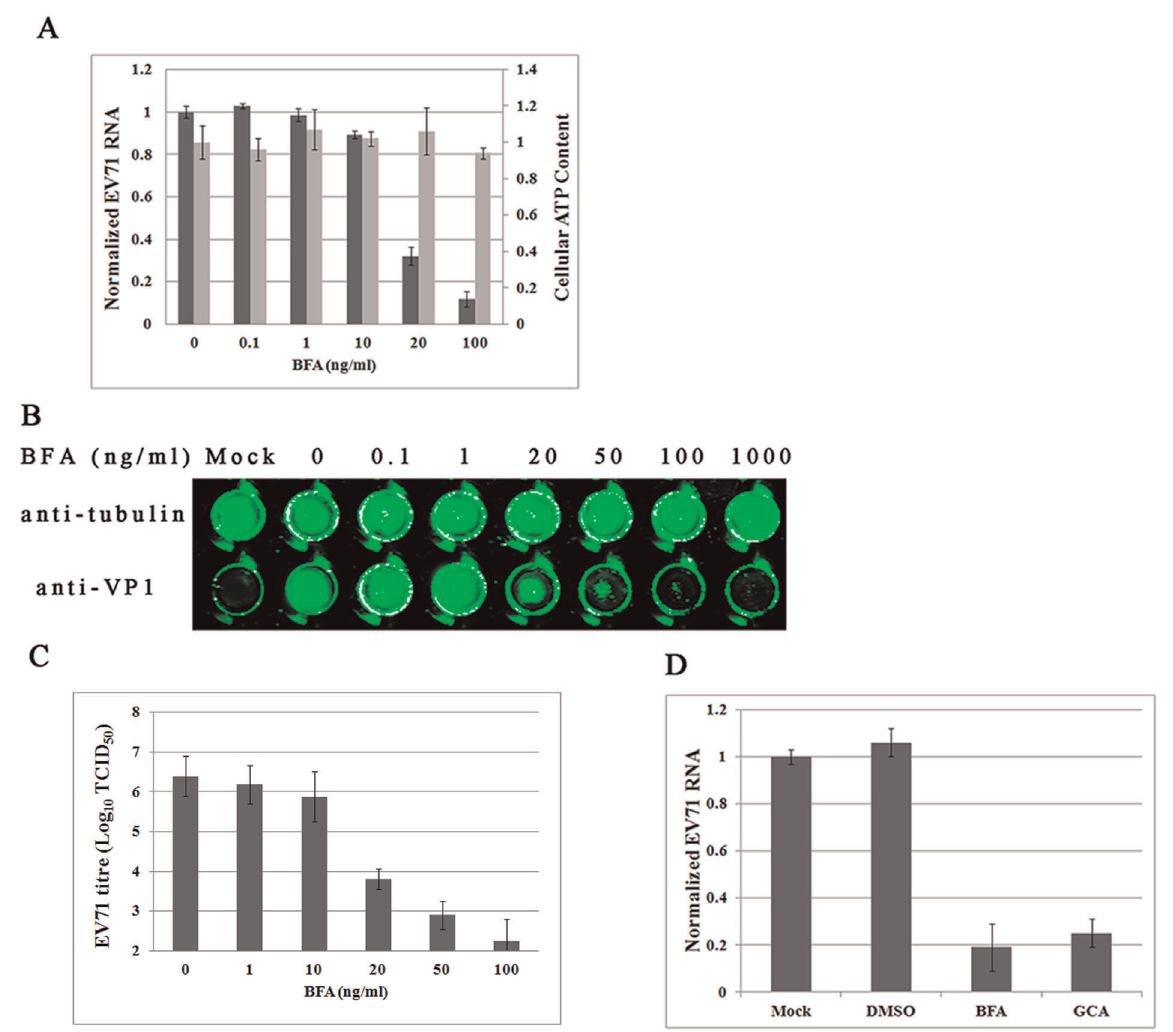
Figure 4. EV71 infection is inhibited by BFA. RD cells were infected with EV71 at 0.1 MOI with various concentrations of BFA. (A) Concentrations of 20 ng/ml BFA or higher significantly inhibited EV71 replication ( P , 0.05). Standard deviations of three independent experiments are shown. (B) Viral VP1 protein and internal cell tubulin protein was detected by in-cell Western blot. Concentrations of 20 ng/ml or higher BFA inhibited VP1 expression. (C) Viral titre was suppressed by 20 ng/ml or higher BFA ( P , 0.05). Standard deviations of three independent experiments are shown. (D) 50 ng/ml GCA inhibited EV71 replication in RD cells ( P , 0.05). Standard deviations of three independent experiments are shown.